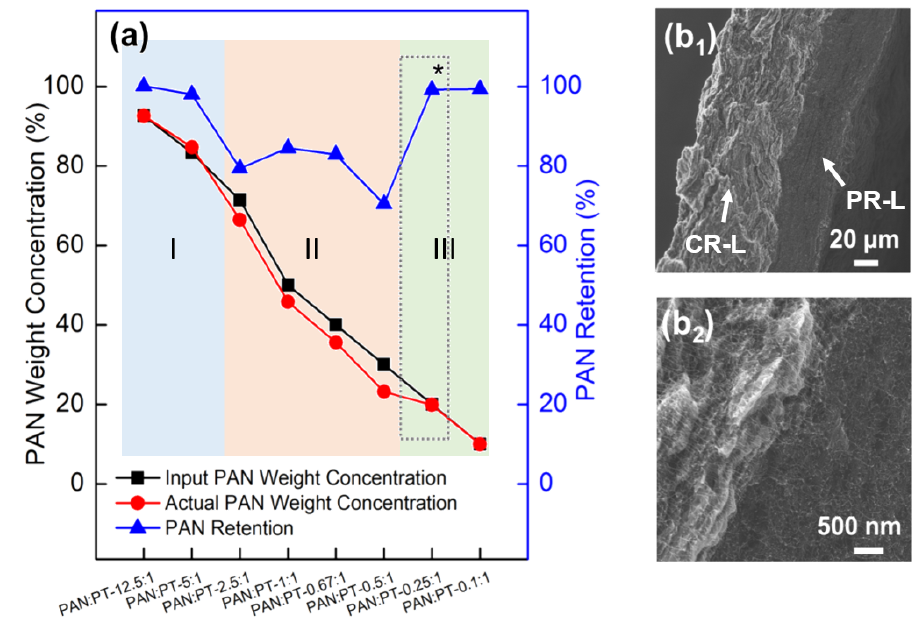
Figure 5. ( a ) PAN weight fraction and retention curves for the hPBPs. The asterisk denotes the ideal loading ratio v*. ( b ) Electron micrographs of the 0.25:1 hPBP showing resolved PRL and CRL regions with distinct SWNT